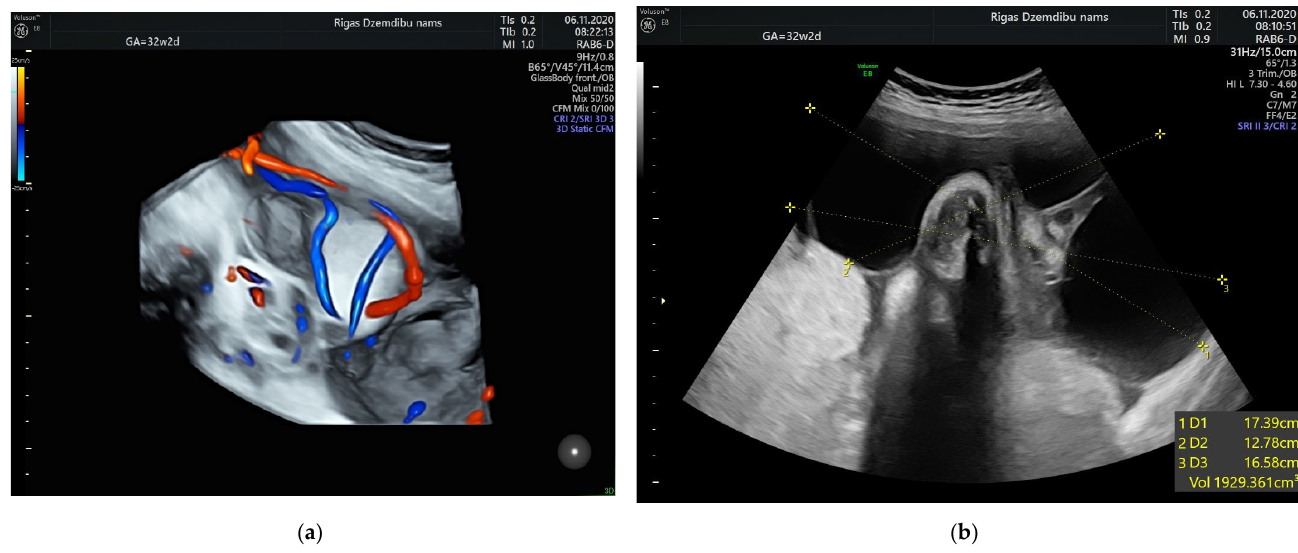
Figure 2. ( a ) Umbilical vessels going through the tumor at 32 + 2 weeks by 3D static HD flow (glass mode) imaging; ( b ) Tumor appearance at 32 + 2 weeks.